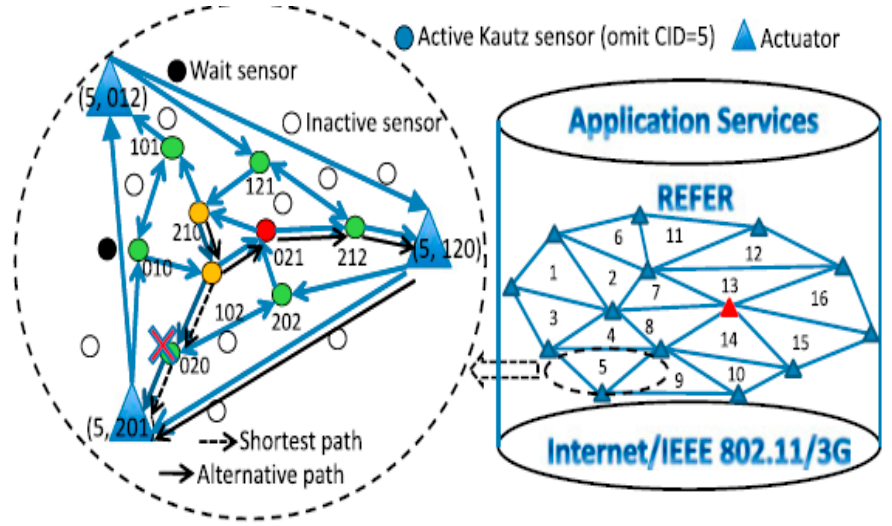
Figure 6. The architecture of the REFER system [48] (source node 210 wants to send an event report to node 201, and it sends the report along the route 210 → 102 → 020 → 201 where “ → ” denotes an unidirectional link. In the case that node 020 is broken, node 102 can independently find out an alternative route, namely 102 → 021 → 212 → 120 → 201, to route the report to the destination without requiring the source node to retransmit the report).